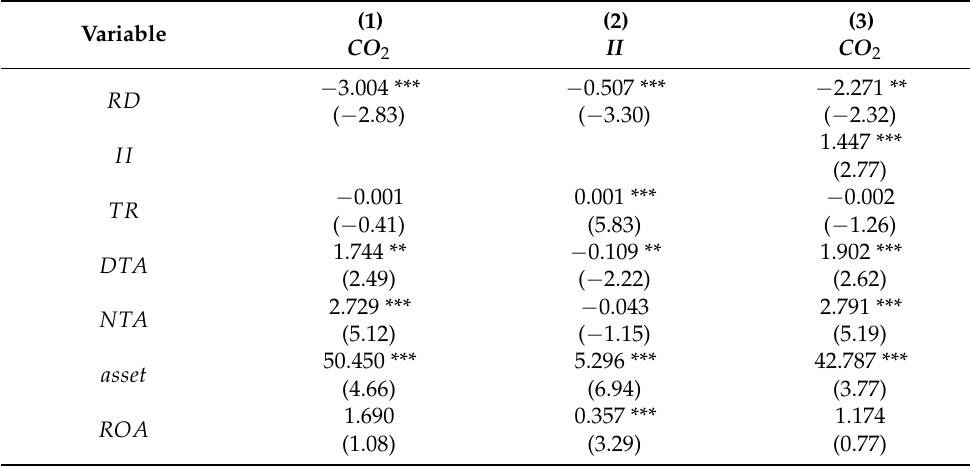
Table 7. Regression results after changing the core explanatory